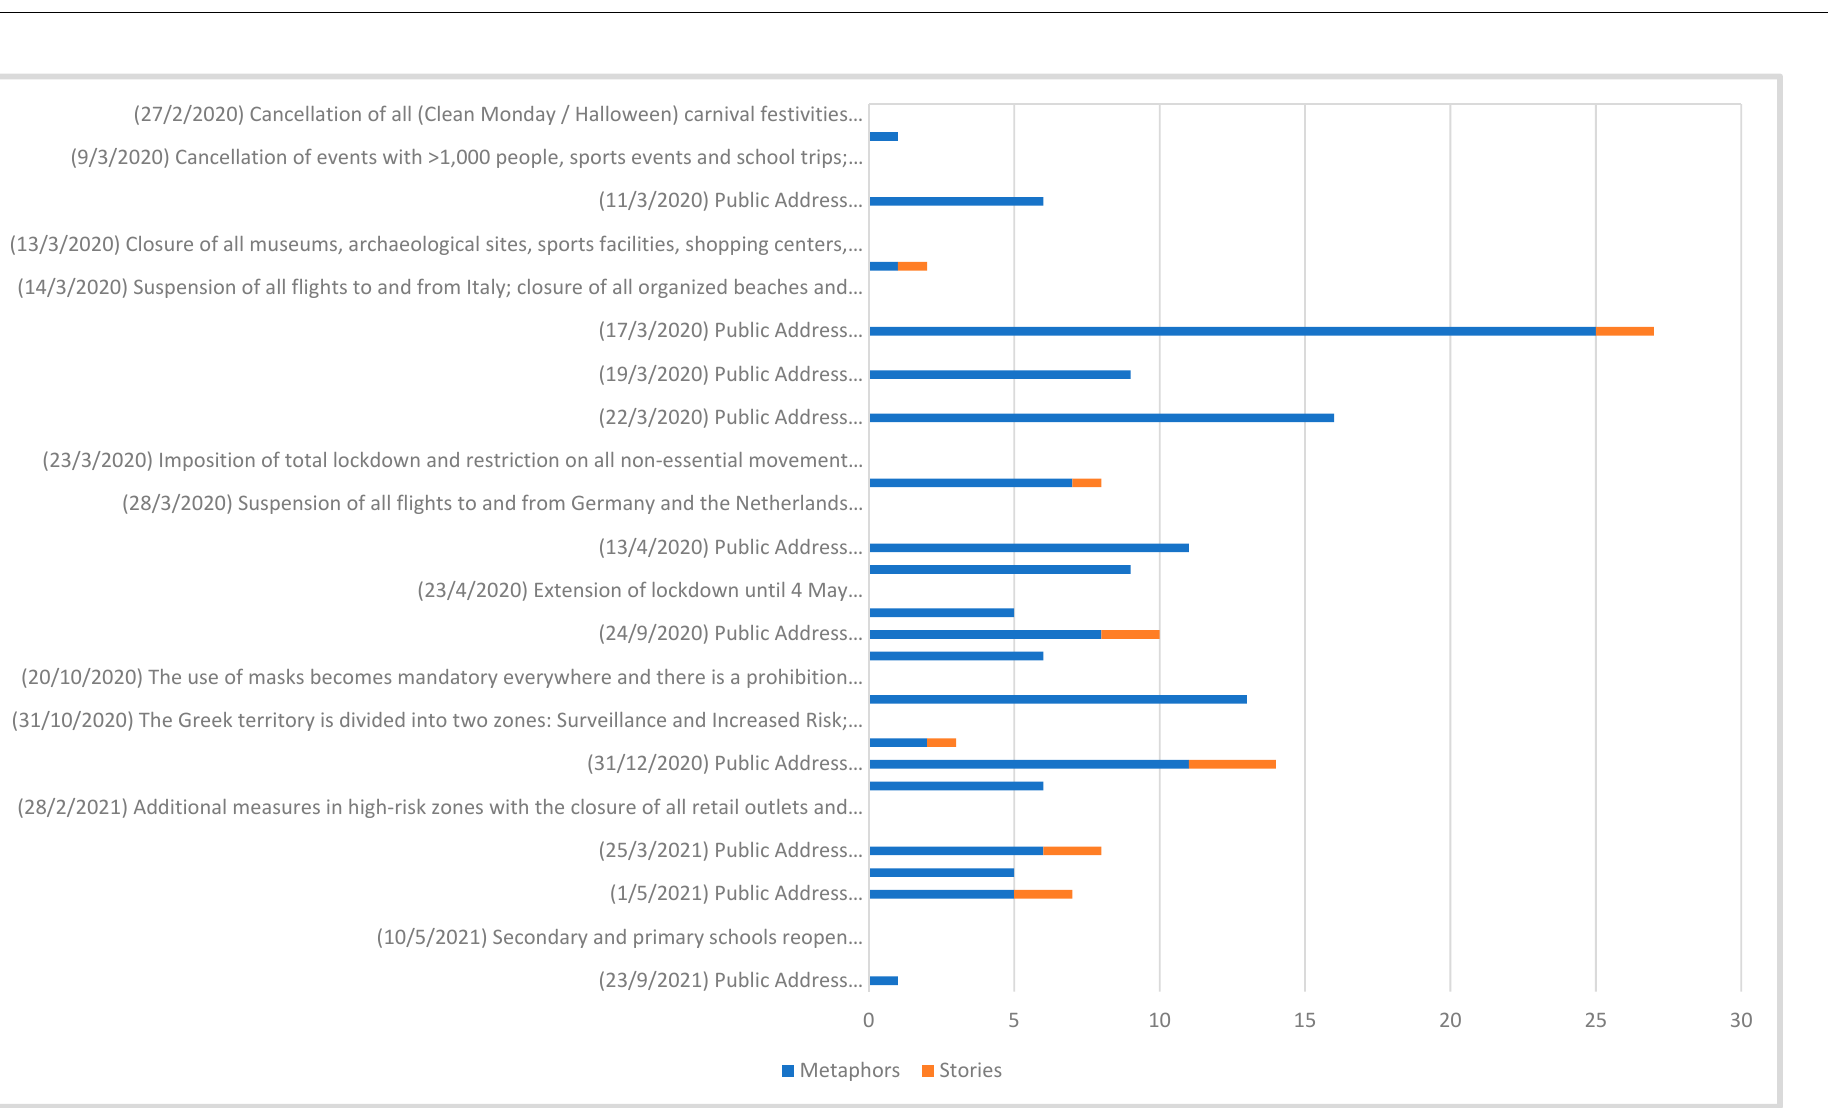
Figure 4. Number of Metaphors and Stories used by the Greek PM in his speeches Positioned in the Timeline of Events.